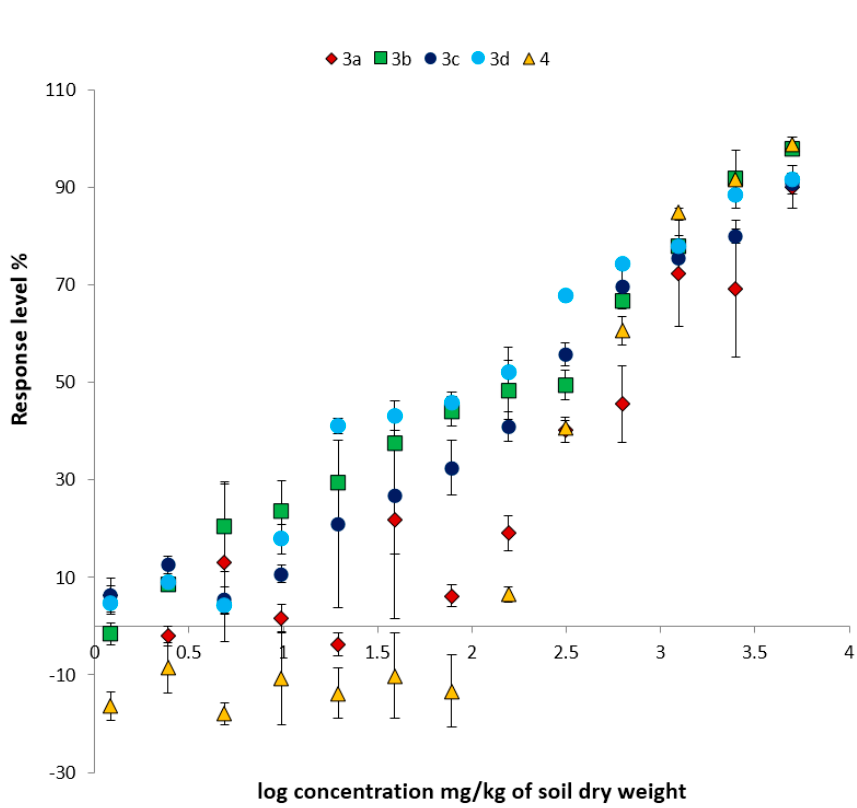
Figure 1. The EC 50 graded dose-response curves for the five tested compounds 3a – d and 4 . Overlapped curves are plotted by the Microtox ® Analyzer 500 software. Error bars represent standard deviation error (SD, n = 3 determinations).